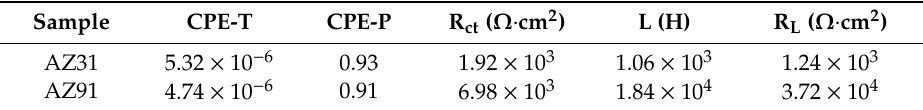
Figure 4. Bode plots ( a , b ) for the bare AZ31 and AZ91 Mg alloys after immersion in 0.1 M NaCl solution for 0.5 h. The illustration in ( a ) is the equivalent circuit model for fitting the Bode plots. Table 1. EIS fitting results for the bare AZ31 and AZ91 Mg alloys after immersion in 0.1 M NaCl solution for 0.5 h.